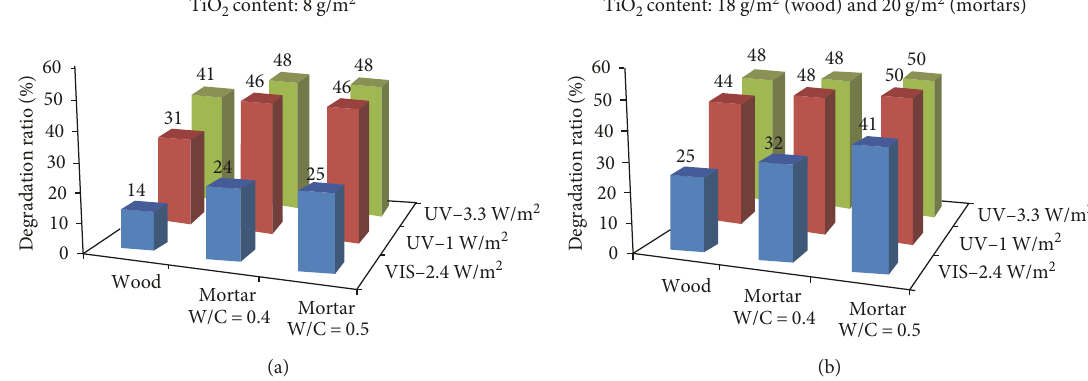
Figure 10: In fl uence of substrate nature on NO degradation ratio (in %) for two TiO each substrate under three di ff erent illumination conditions: (a) 8g/m 2 applied to all substrates, (b) 18g/m 2 applied to wood, and 20g/m 2 applied to mortars. The accuracy of the measurements is ±